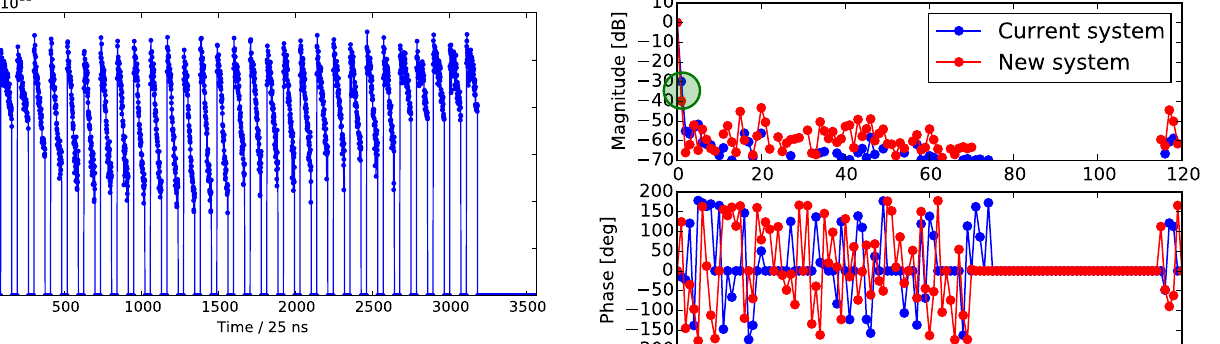
FIG. 6. Typical bunch intensity pattern for the 25 ns beams, with triangular bunch trains due to particle loss from the e-cloud effect. The last five bunch trains were injected later and they were still losing particles. Beam 1. Fill 2251 (25-10-2011).